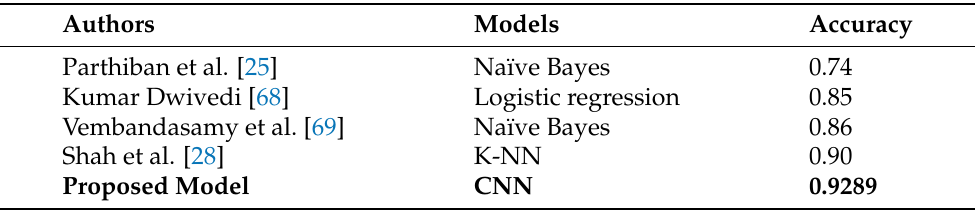
Table 11. Comparison of the proposed approach with the existing